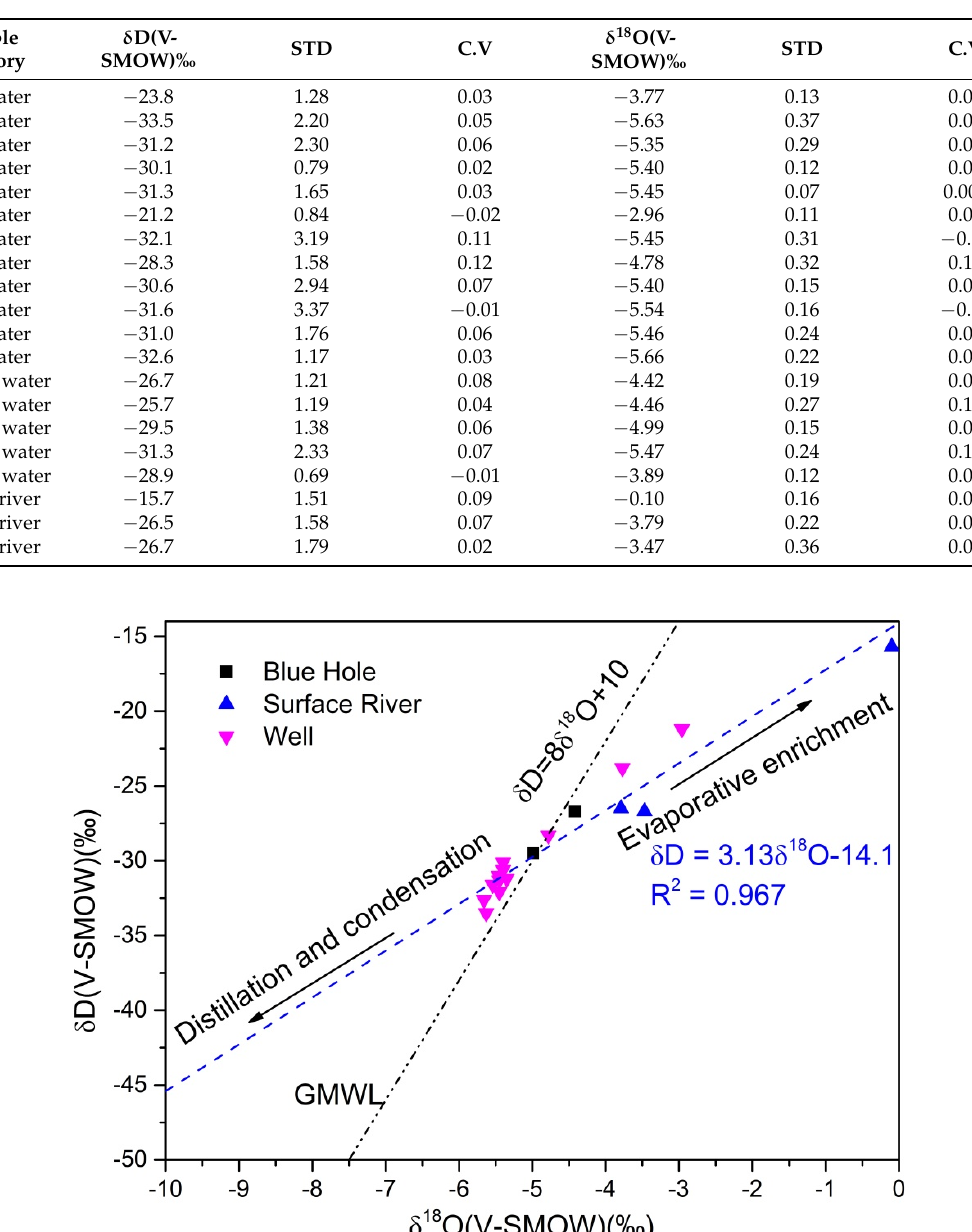
Table 2. Statistics for δ D and δ 18 O values.